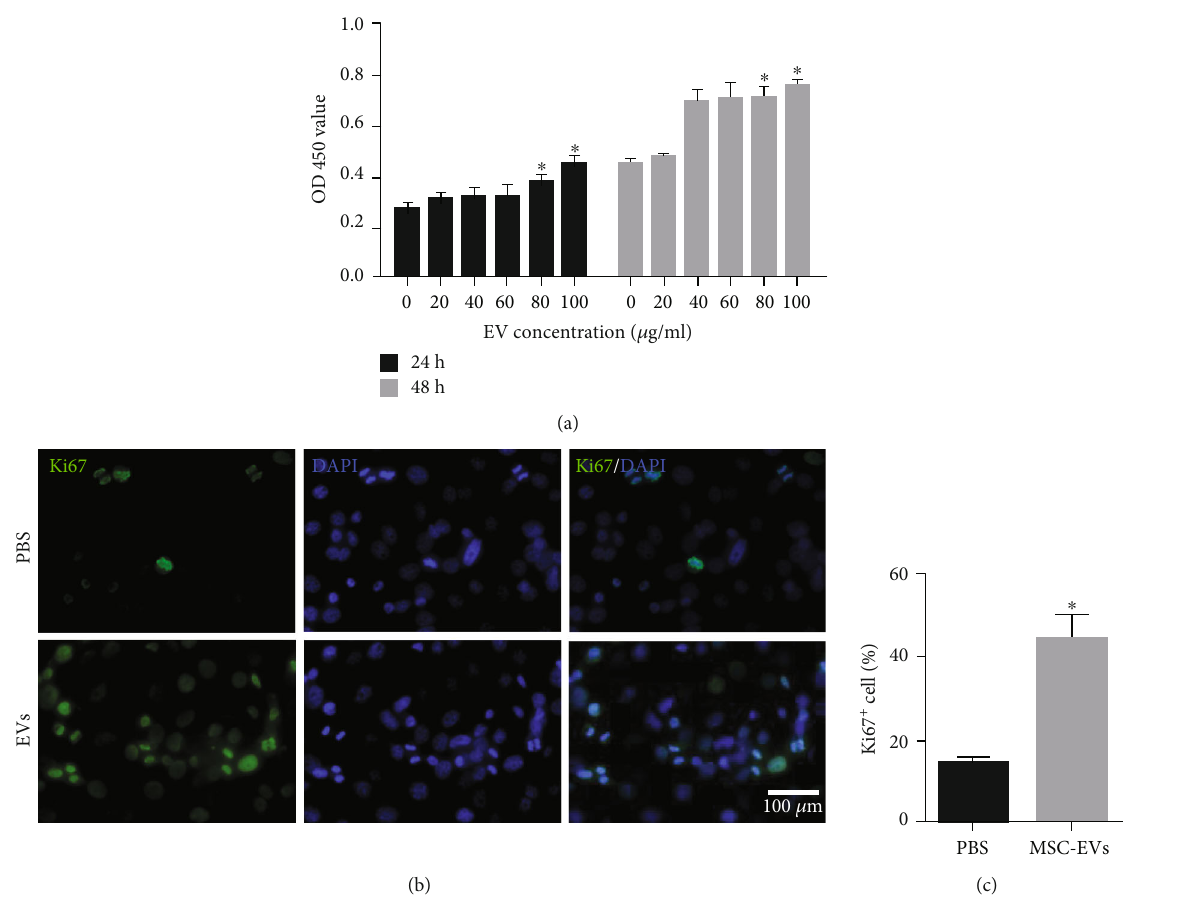
Figure 2: The proliferative e ff ects of hMSC-derived EVs on HCEs. (a) MTT assay revealed the increased proliferation of HCEs under EV treatment with a dose-dependent manner (the concentration of EVs was increased from 0 to 100 μ g/mL, using PBS for dilution). (b, c) Ki-67 staining showed that the proliferation of HCEs was signi fi cantly improved after incubating with EVs and lasts for 48h. All data is shown as means ± SEM in triplicate assays. ∗ P < 0 : 05 versus